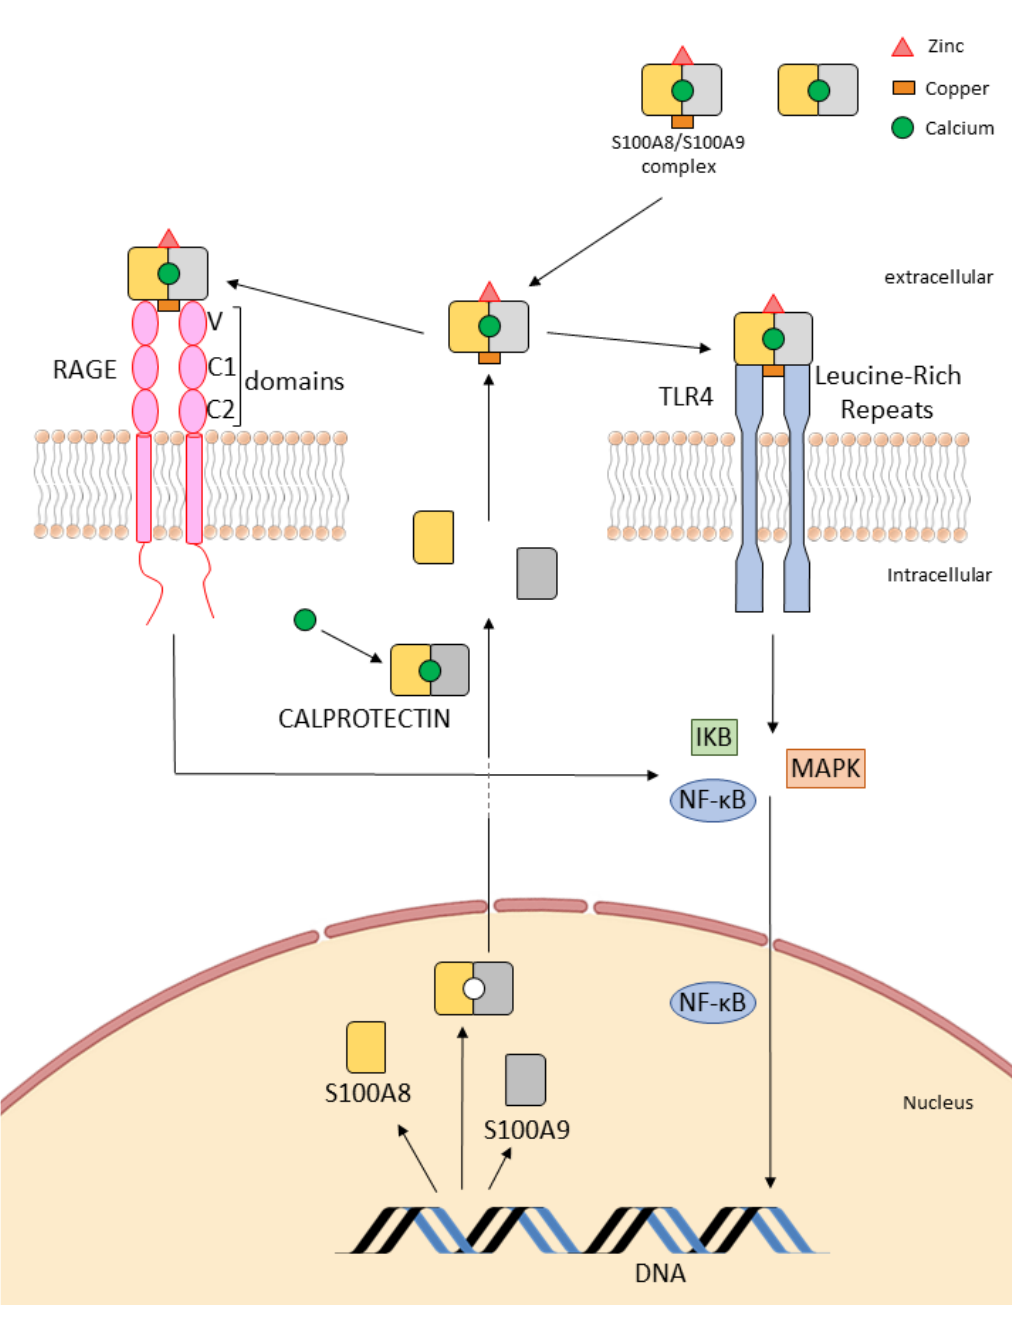
Figure 1. Schematic structure of S100A8/S100A9 complex, calprotectin (CLP), RAGE/TLR4 receptors and intracellular activity. The receptor for advanced glycation end products (RAGE) and toll-like receptor 4 (TLR4) are multiligand receptors. The ectodomain of RAGE is composed of three domains. The receptor is anchored in the plasma membrane by a single transmembrane helix and exhibits in the cytoplasm a short tail. Ligation of extracellular RAGE by S100A8/A9 complex promotes the homodimerization of RAGE. TLRs are type I transmembrane receptors characterized by an N-terminal extracellular domain, a single transmembrane domain and a C-terminal intracellular signaling domain. TLR4 exist as monomers in membrane before stimulation and dimerization induced by ligand recognition upon stimulation. CLP is a heterodimeric complex formed by two binding proteins of the calcium ion. CLP is the heterodimer of the proteins S100A8 and S100A9. Each monomer is able to bind calcium ions and can also bind other divalent metal ions such as zinc and copper. S100A8/A9 and CLP bind to RAGE and TLR4 receptors initiating signal transduction through NF- κ B pathways and promoting increased S100A8/A9 and CLP